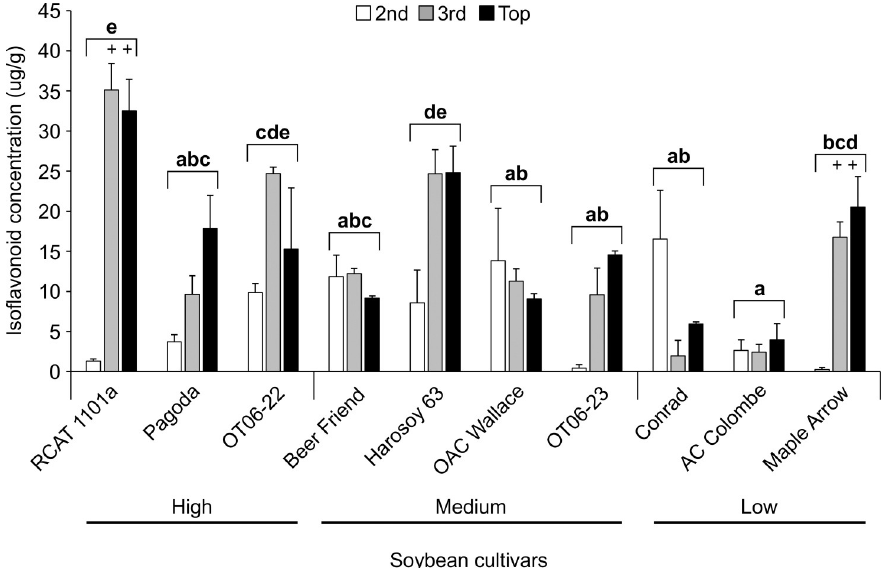
Fig 3. The effect of two-spotted spider mite feeding on isoflavonoid concentrations in the 2 nd , 3 rd and top full leaves of 10 soybean cultivars after 10 days. Data are mean ( ± S.E.) isoflavonoid concentrations ( μ g/g). Bracketed bars for each cultivar with the same letters are not statistically different (2-way ANOVA, Tukey’s pairwise comparison, P > 0.05). Analysis of the mid-leaflet of the trifoliate leaves indicated that there was no significant difference (P > 0.05) in isoflavonoid concentrations between the 3 leaf levels, with the exception of 2 cultivars where the 2 nd full leaves had lower (++ = P < 0.05) isoflavonoids than the 3 rd full and top leaflets.